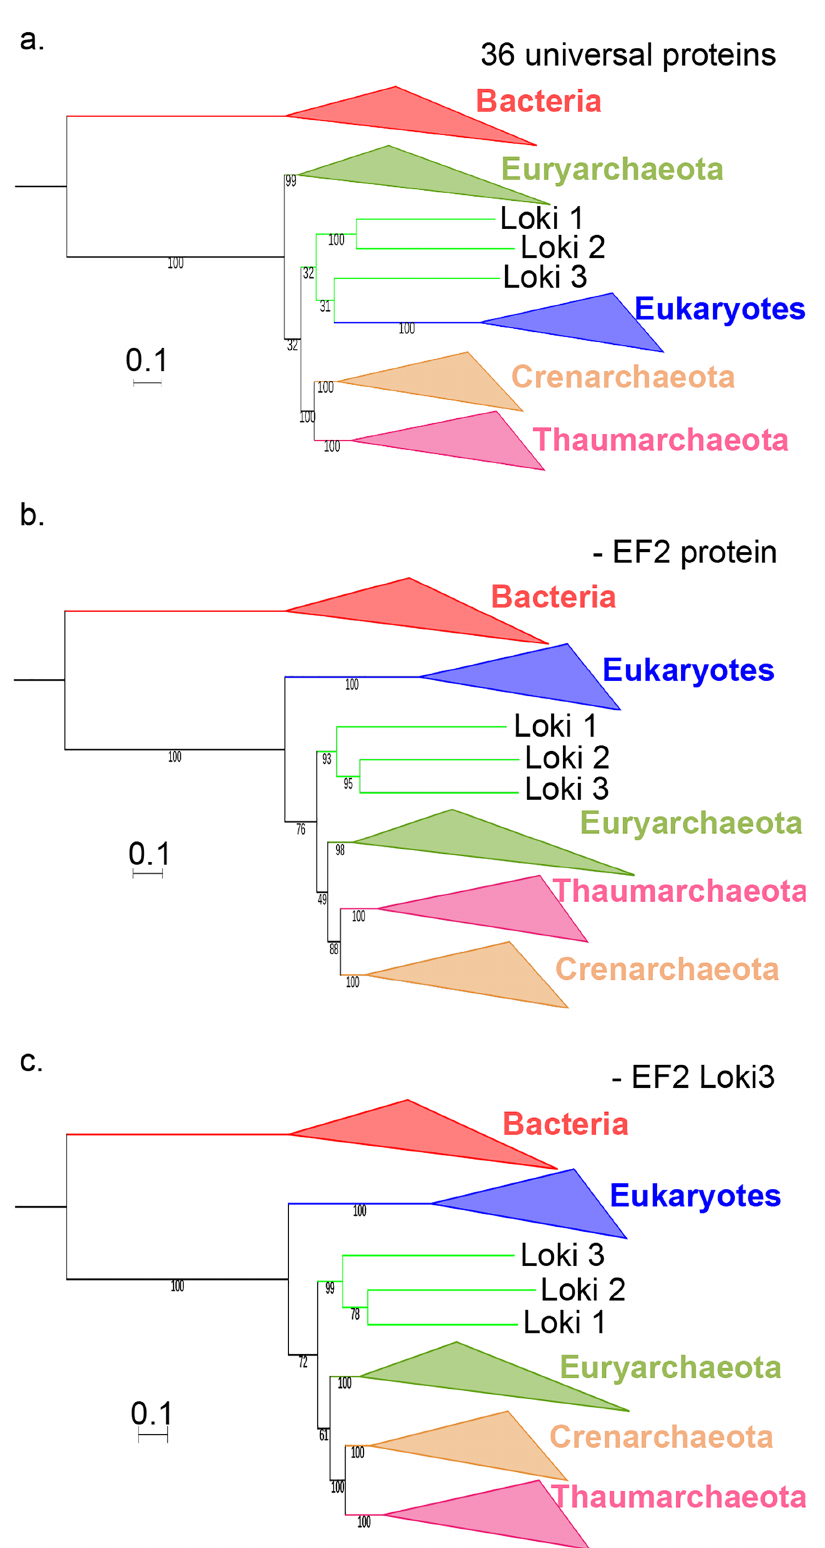
Fig 5. Impact of the EF2 protein on the concatenation of the curated datasets. a. ML phylogenetictree of the concatenated curated datasets (8,367 positions). b. ML phylogenetic tree of the concatenated